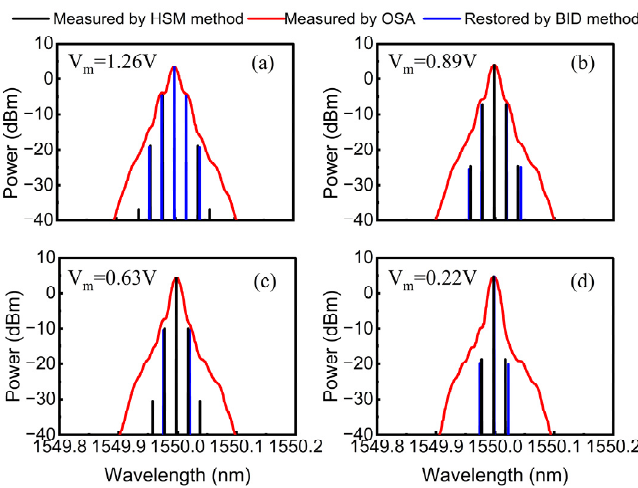
Figure 7. Measured modulation spectra by OSA, the restored intrinsic modulation spectral lines by using BID method, and measured modulation spectral lines based on HSM method under different driving amplitudes ( a )–( d ).